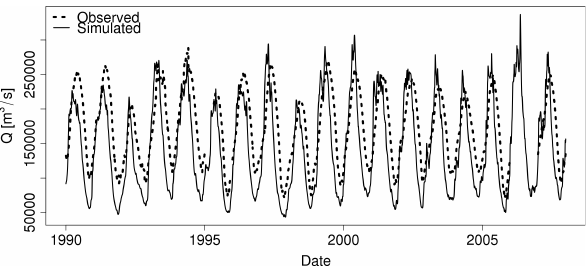
Fig. 3. Comparison between observed and simulated daily average discharge in the Amazon River at ´Obidos, linigrafo ,